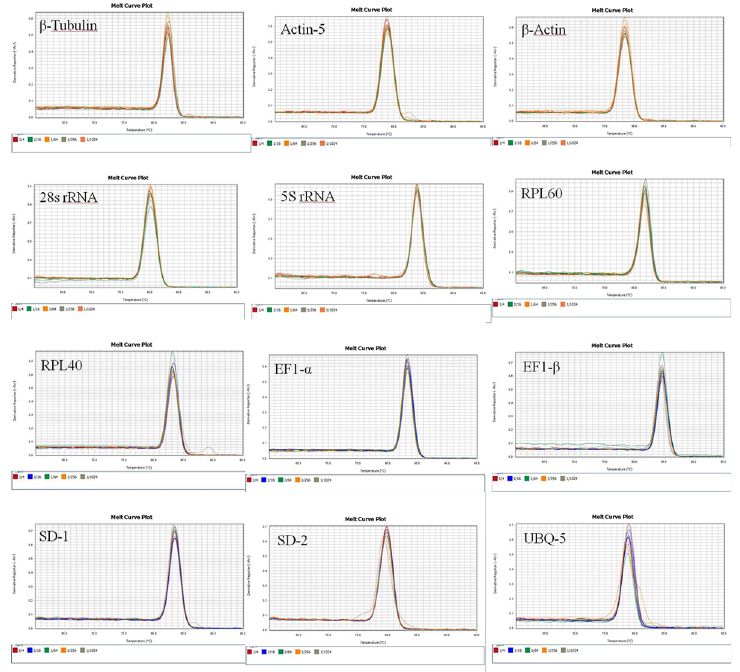
Fig 2. Melting curves of 12 candidate reference genes for qRT-PCR amplification.